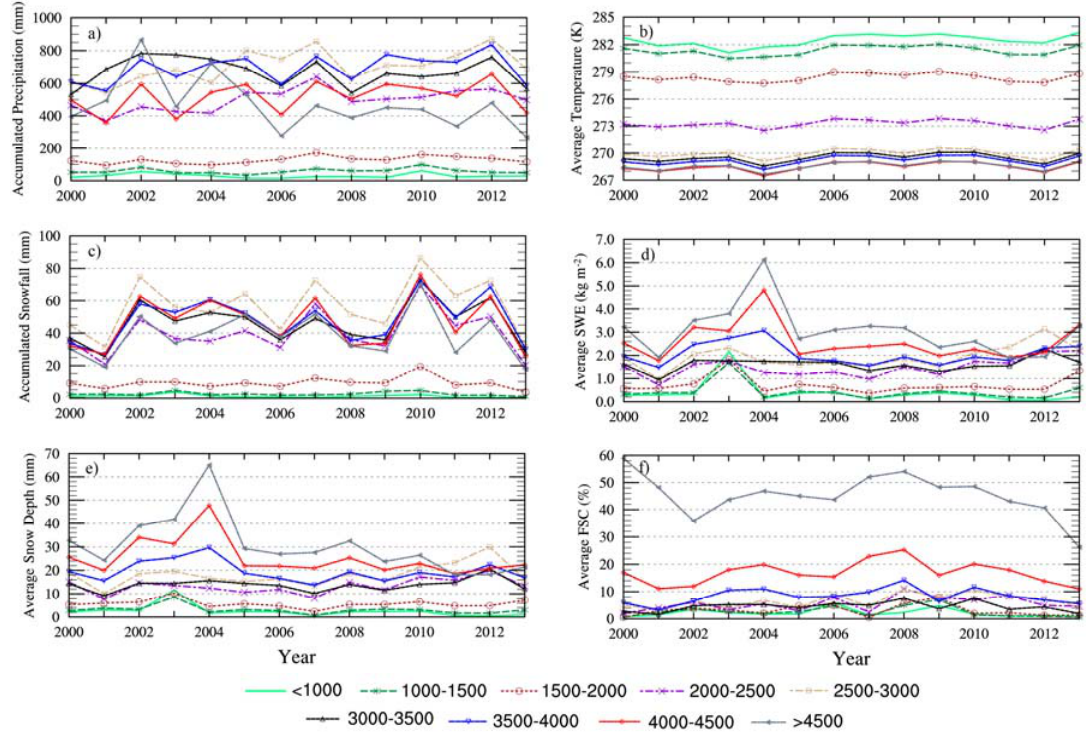
Figure 6. Annual mean values by altitude from 2000 to 2013: ( a ) precipitation; ( b ) 2m temperature; ( c ) snowfall; ( d ) SWE; ( e ) snow depth; ( f ) FSC.